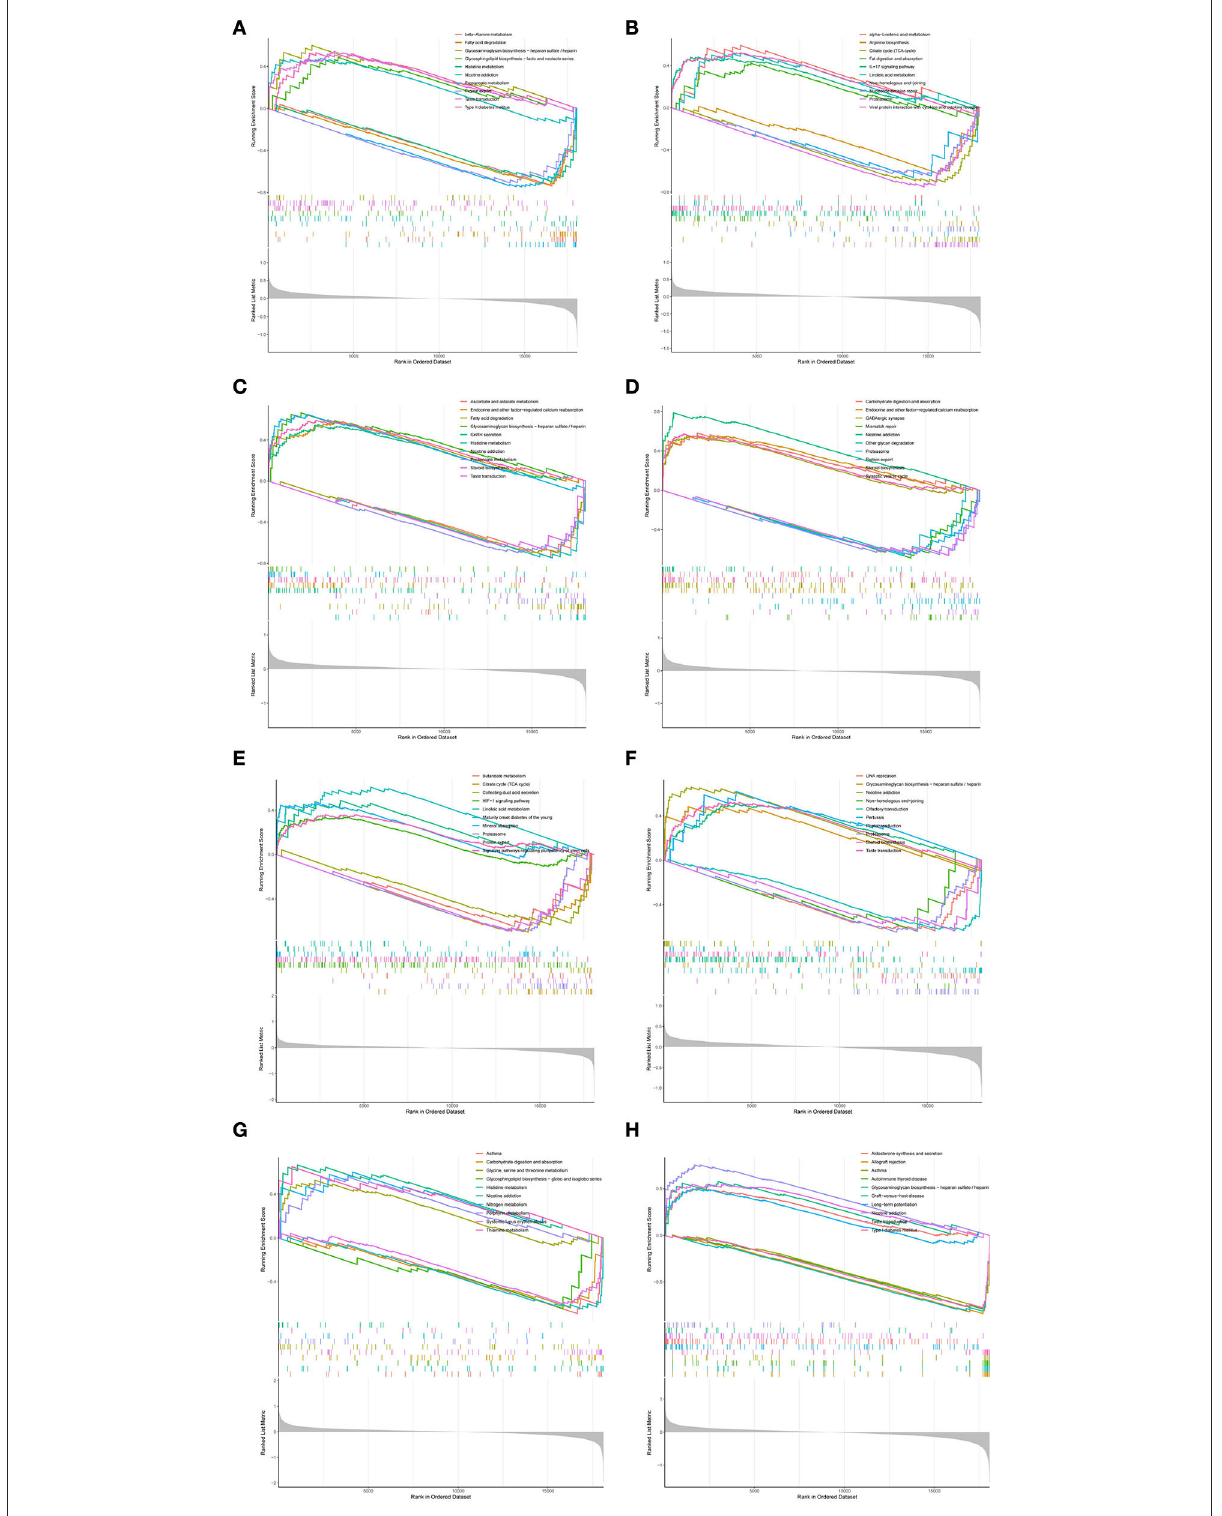
FIGURE7 GSEA of hub genes: (A) GSEA results for CD99P1 ; (B) GSEA results for DLG3-AS1 ; (C) GSEA results for LINC01101 ; (D) GSEA results for LOC100133130 ; (E) GSEA results for MELK ; (F) GSEA results for PLEAK2 ; (G) GSEA results for PYCRL ; (H) GSEA results for RPL3L